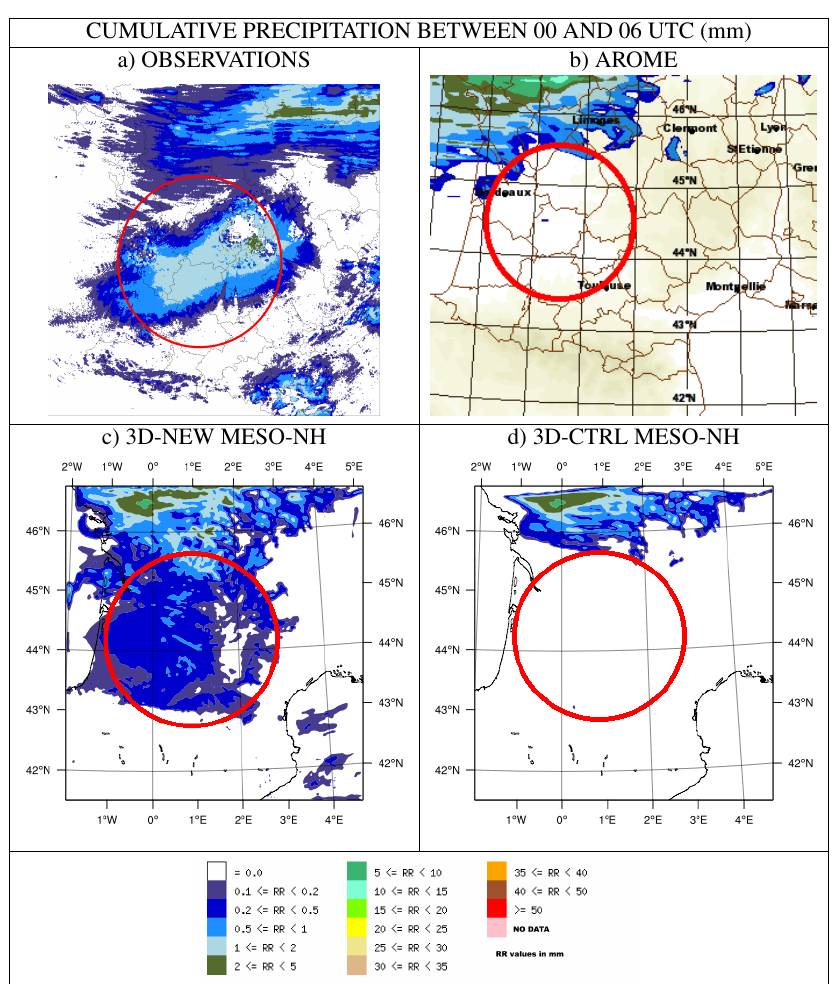
Figure 15: Cumulated precipitation between 00 and 06 UTC in South-West France for March 27, 2009. Fig. 15. Cumulated precipitation between 00:00 and 06:00 UTC in South-West France for 27 March